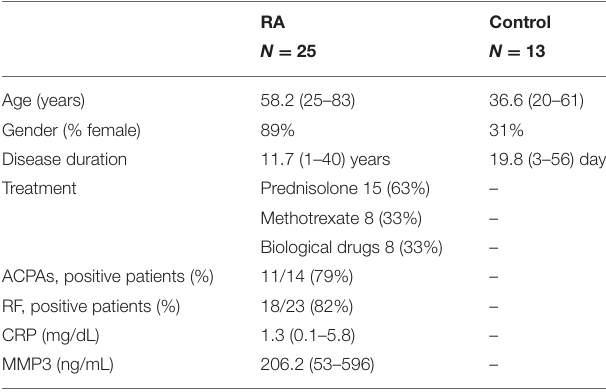
TABLE 1 | Characteristics of patients with RA and acute inflammation (control subjects).